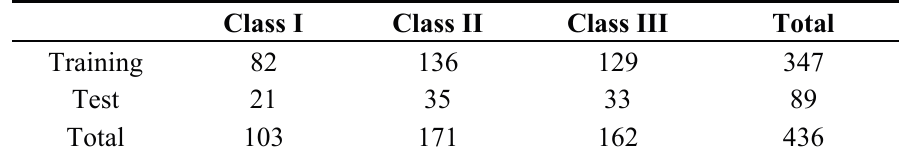
Table 2. The distribution of class I, II and III chemicals into training and test sets based on the principle of keeping 20% of chemicals from each class as a test